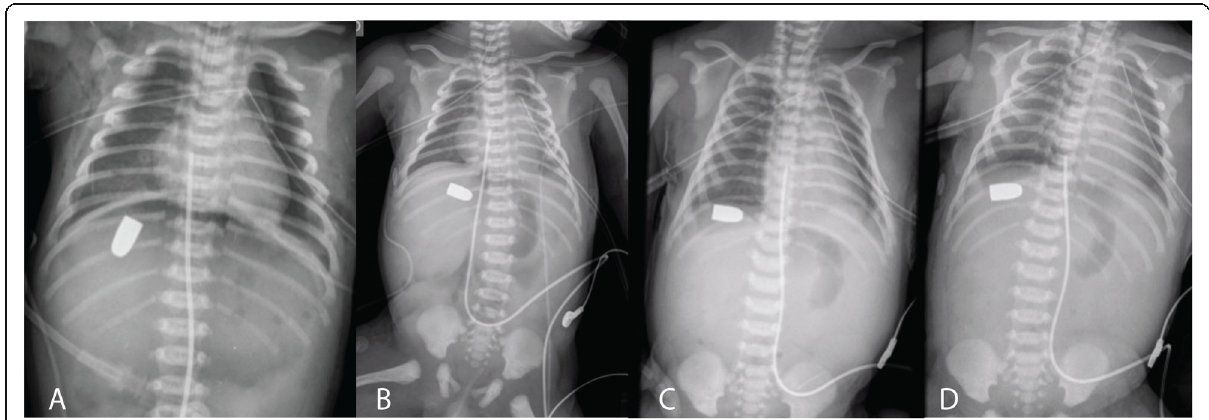
Fig. 1 Front thoracic and abdominal X-ray. Upon arrival ( a ). After 4 h ( b ). After 8 h ( c ). After 12 h ( d